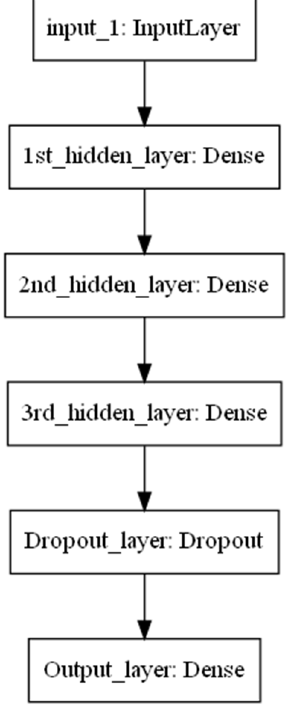
Figure 2. Visual representation of defined model.